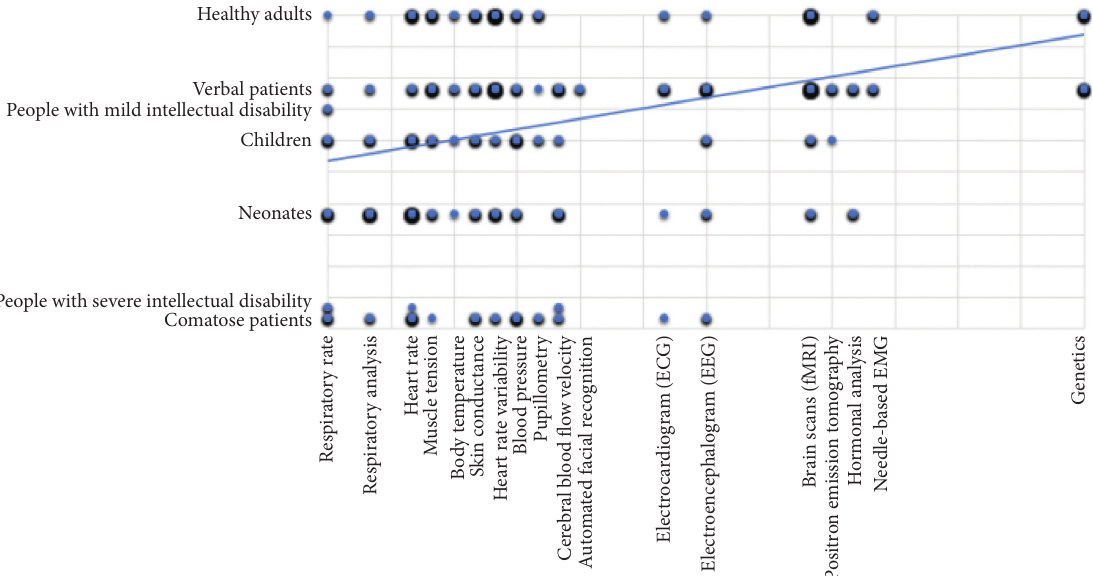
Figure 3: Taxonomy with measurement methods on the x -axis, ordered from least to most invasive, and subject groups on the y -axis, ordered from most to least